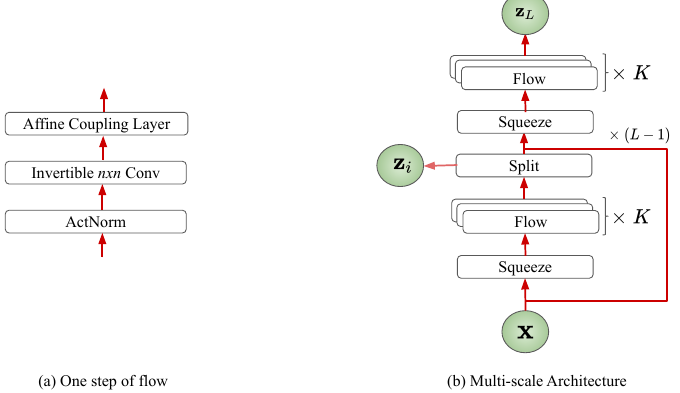
Figure 3. ( a ) is our one step of flow using an invertible n × n convolution. Our proposal flow step is able to combine with the multi-scale architecture designed in RealNVP ( b ). K and L are the depth of flow and the number of levels,